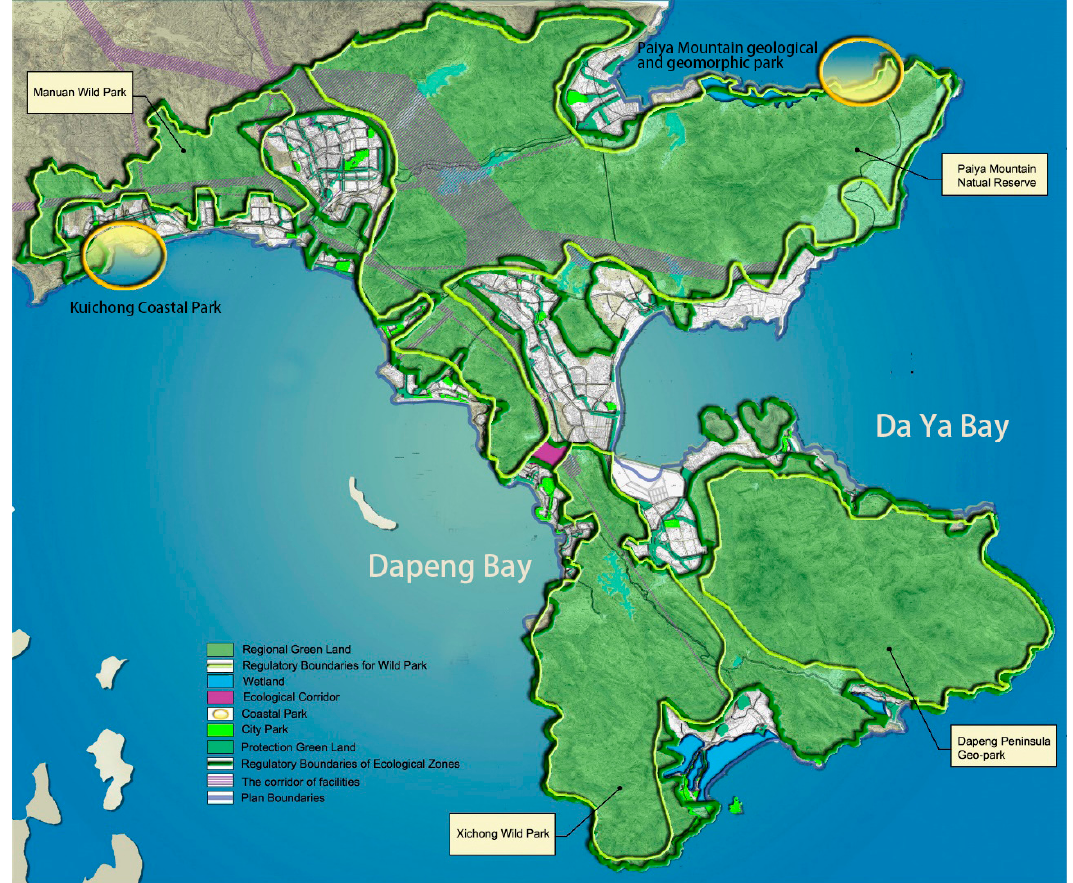
Figure 3. Protected areas in the Shenzhen Eastern Ecological Group Plan (2005–2020). (Source: Author’s compilation based on the Shenzhen Eastern Ecological Group Plan (2005–2020) [44,45]).